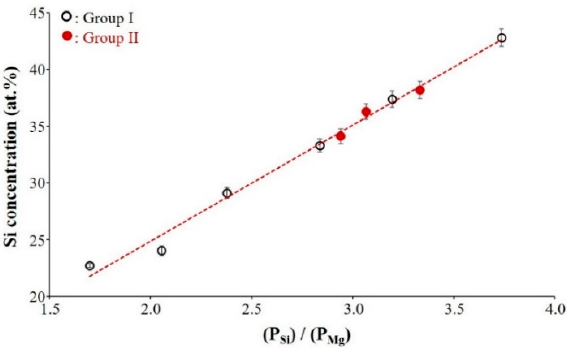
Figure 1. Evolution of the Si atomic concentration in the films measured by Energy-Dispersive X-ray Spectroscopy (EDS) analysis vs. sputtering power ratio applied to each target. (Group I: R P < 7 × 10 − 4 Pa and Group II: R P ≥ 7 × 10 − 4 Pa).